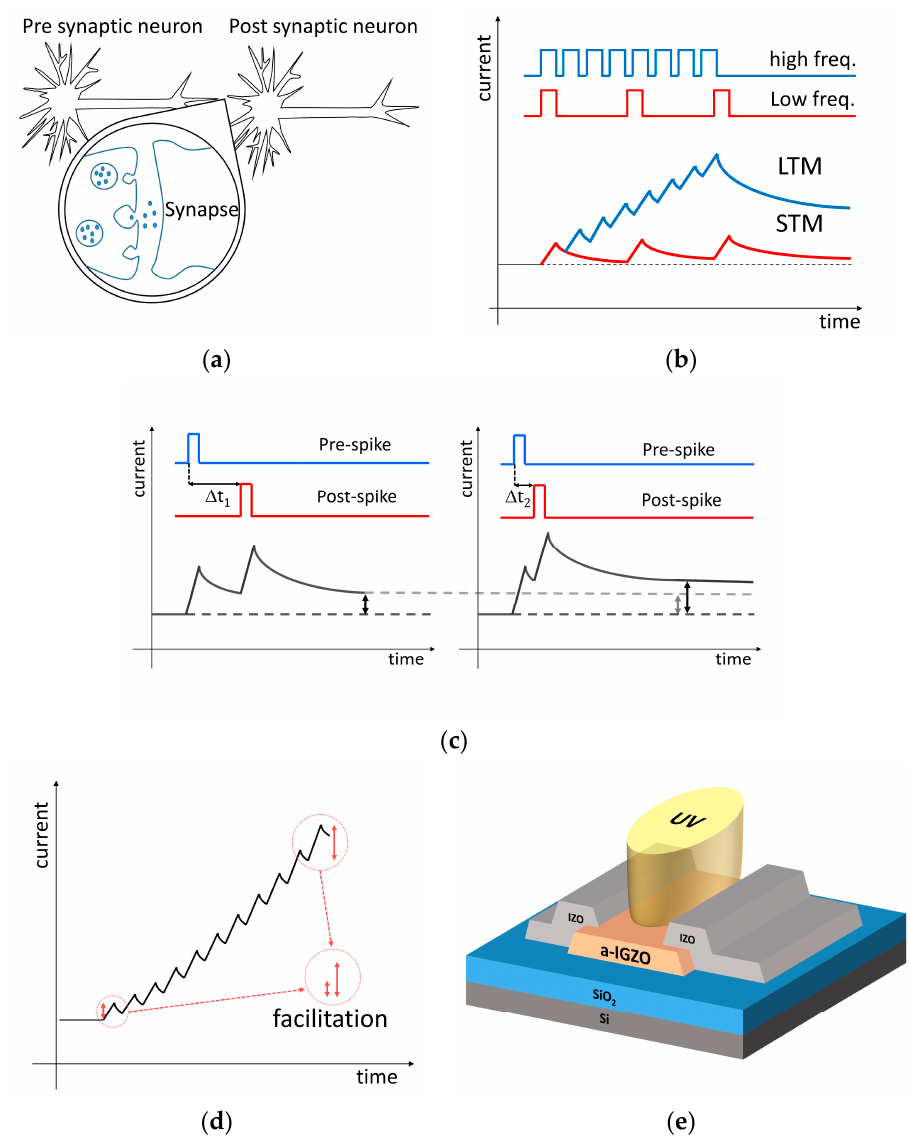
Figure 6. ( a ) Schematic showing neurons and synapses. ( b ) Frequency dependent short-term memory (STM) and long-term memory (LTM). ( c ) Plasticity variation with spike timing interval, spike-timing–dependent plasticity (STDP). ( d ) Facilitation under periodic pulses. ( e ) Device structure (redrawn and adopted from [26]).